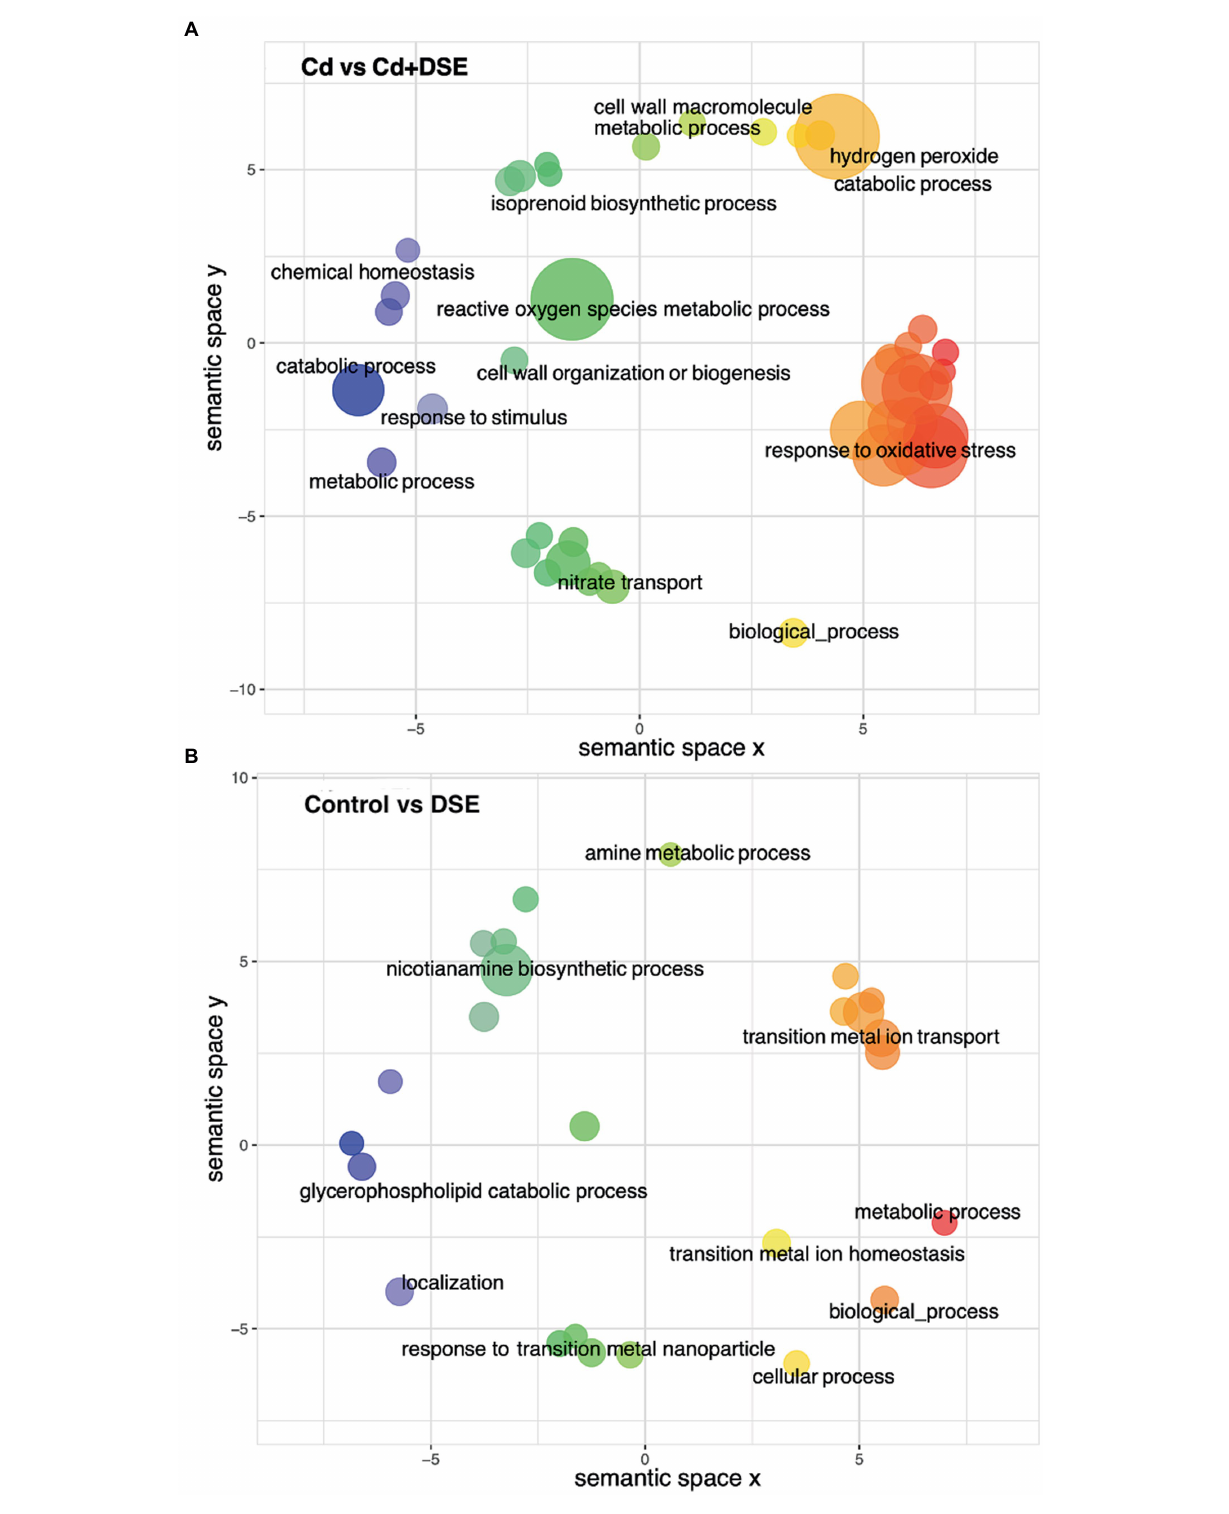
FIGURE 5 Graphical depiction of enriched GO-BPs in (A) Cd vs. Cd + DSE and (B) Control vs. DSE (FDR < 0.05). GO-BP terms are colored by semantic similarity to other GO terms and bubble size reflects the abs_log10_pvalue of the GO-term in the Fisher test. The two-dimensional semantic space was generated by the REVIGO web